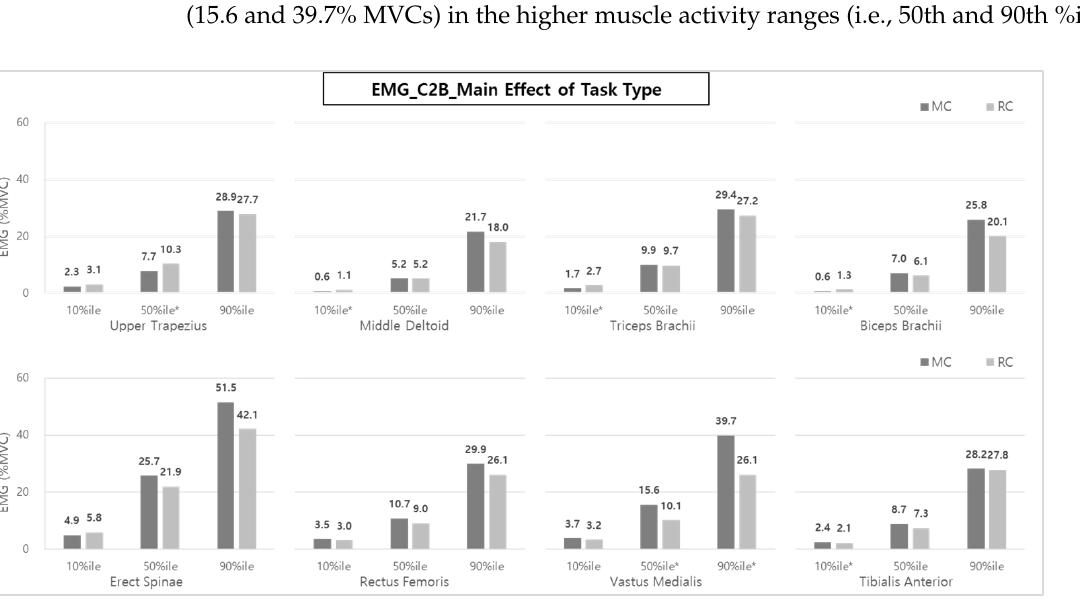
Figure 9. The effect of task type on each muscle activity during C2B. Asterisk (*) indicates that the difference between means is statistically significant at p < 0.05.